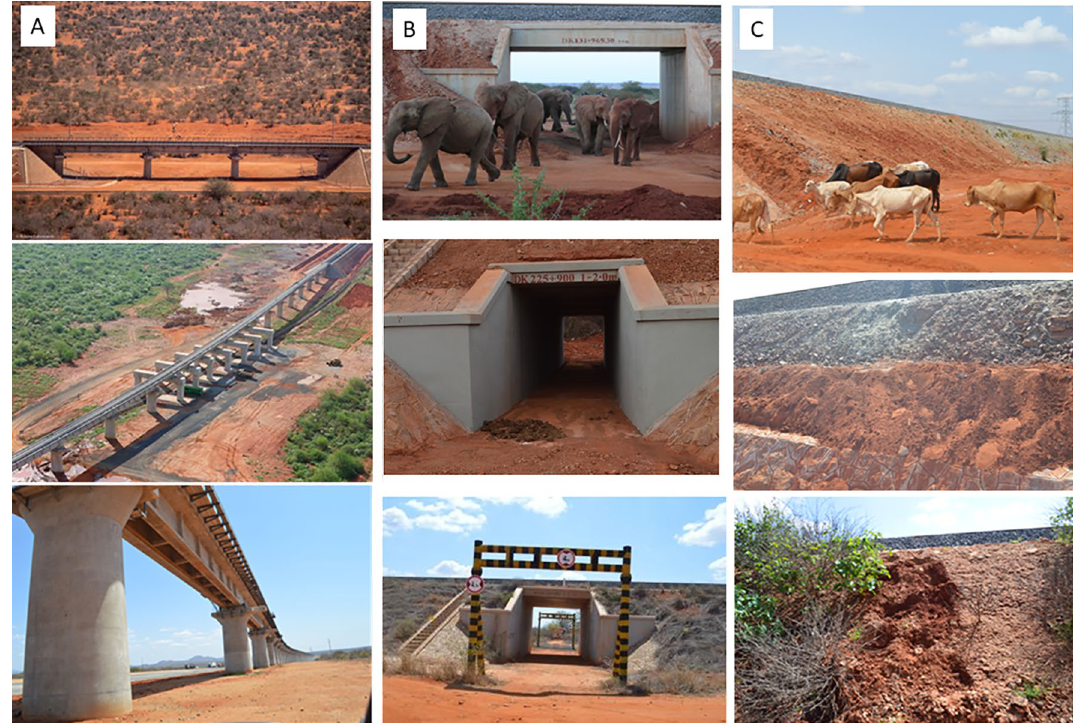
Figure 2. Wildlife crossings were classified as bridges ( A ), culverts ( B ), and embankments ( C ) along the standard gauge railway in Tsavo National Parks,